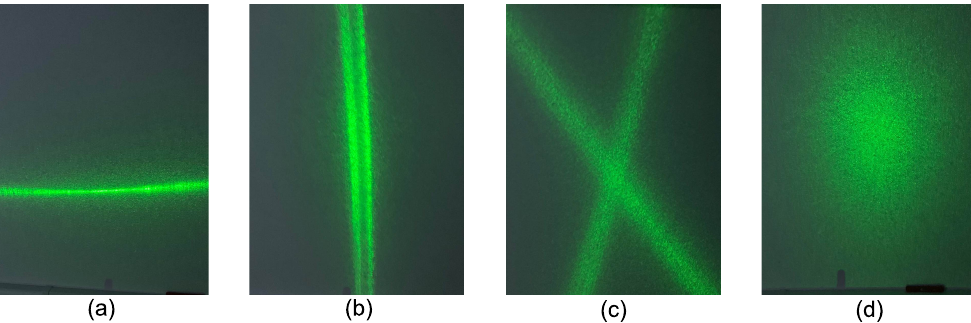
Figure 6. Comparison of reflections from four specimens with a surface roughness of 0.8 µ m. Despite having the same R a value, there is a significant difference between the reflections. In ( a ) horizontal milling, ( b ) vertical milling, and ( c ) honing, highly directional responses are seen, with the light following the direction of the machining tool. In contrast, a nearly Gaussian reflection is seen from ( d ) grit